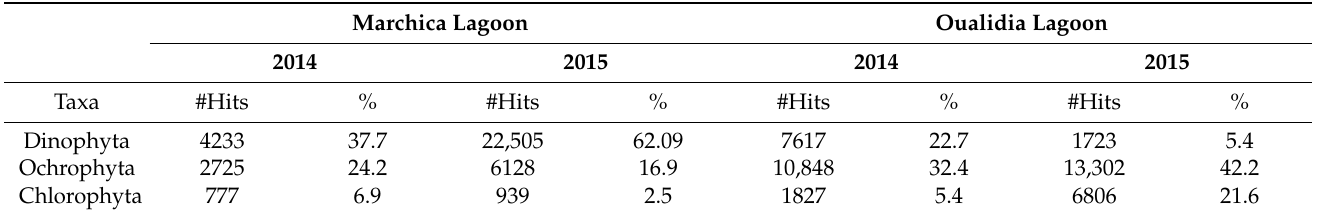
Table 7. 18S SSU rRNA amplicons from selected high abundant sequences assigned to a phylum for both sampling campaigns 2014 and 2015 in both lagoons.